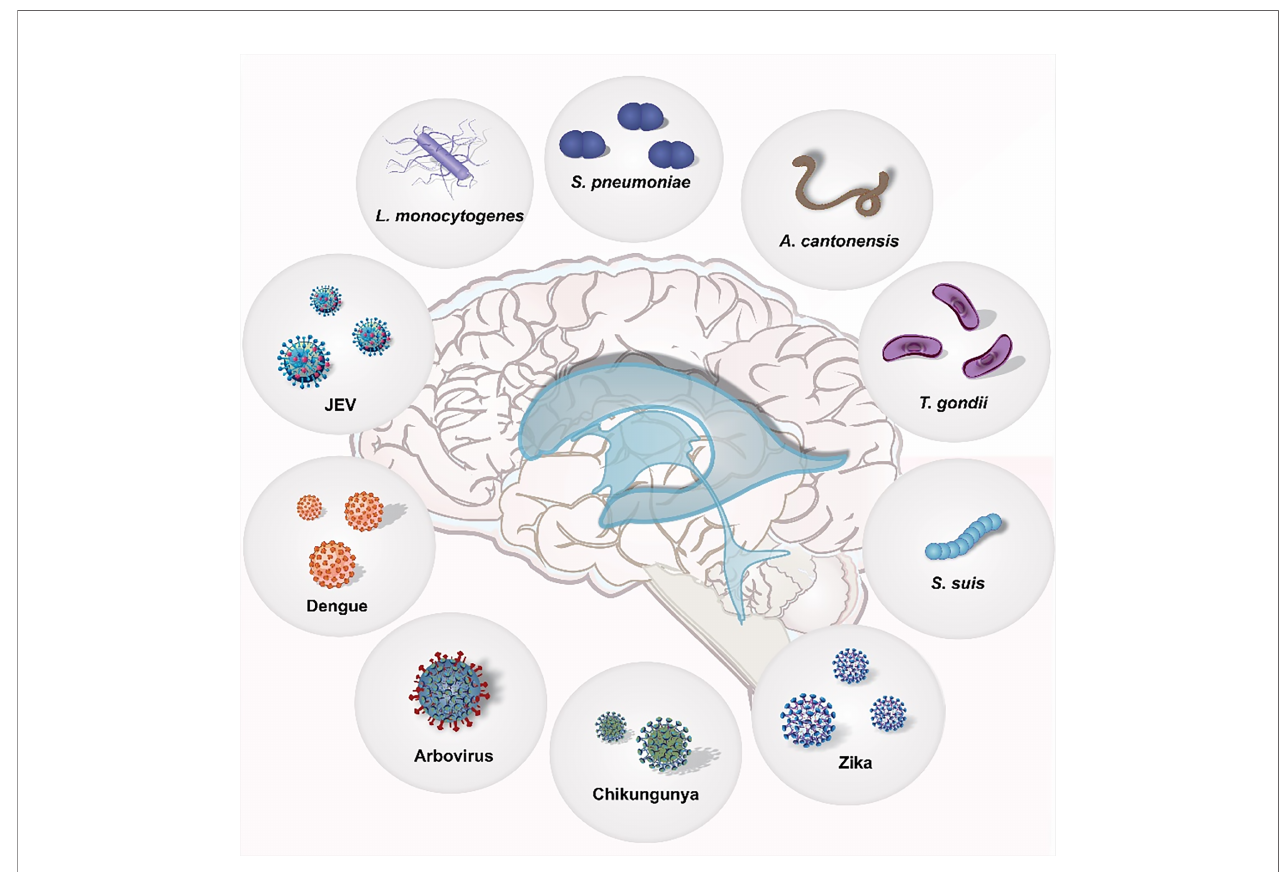
FIGURE 1 | The host-pathogen interaction in the Central Nervous